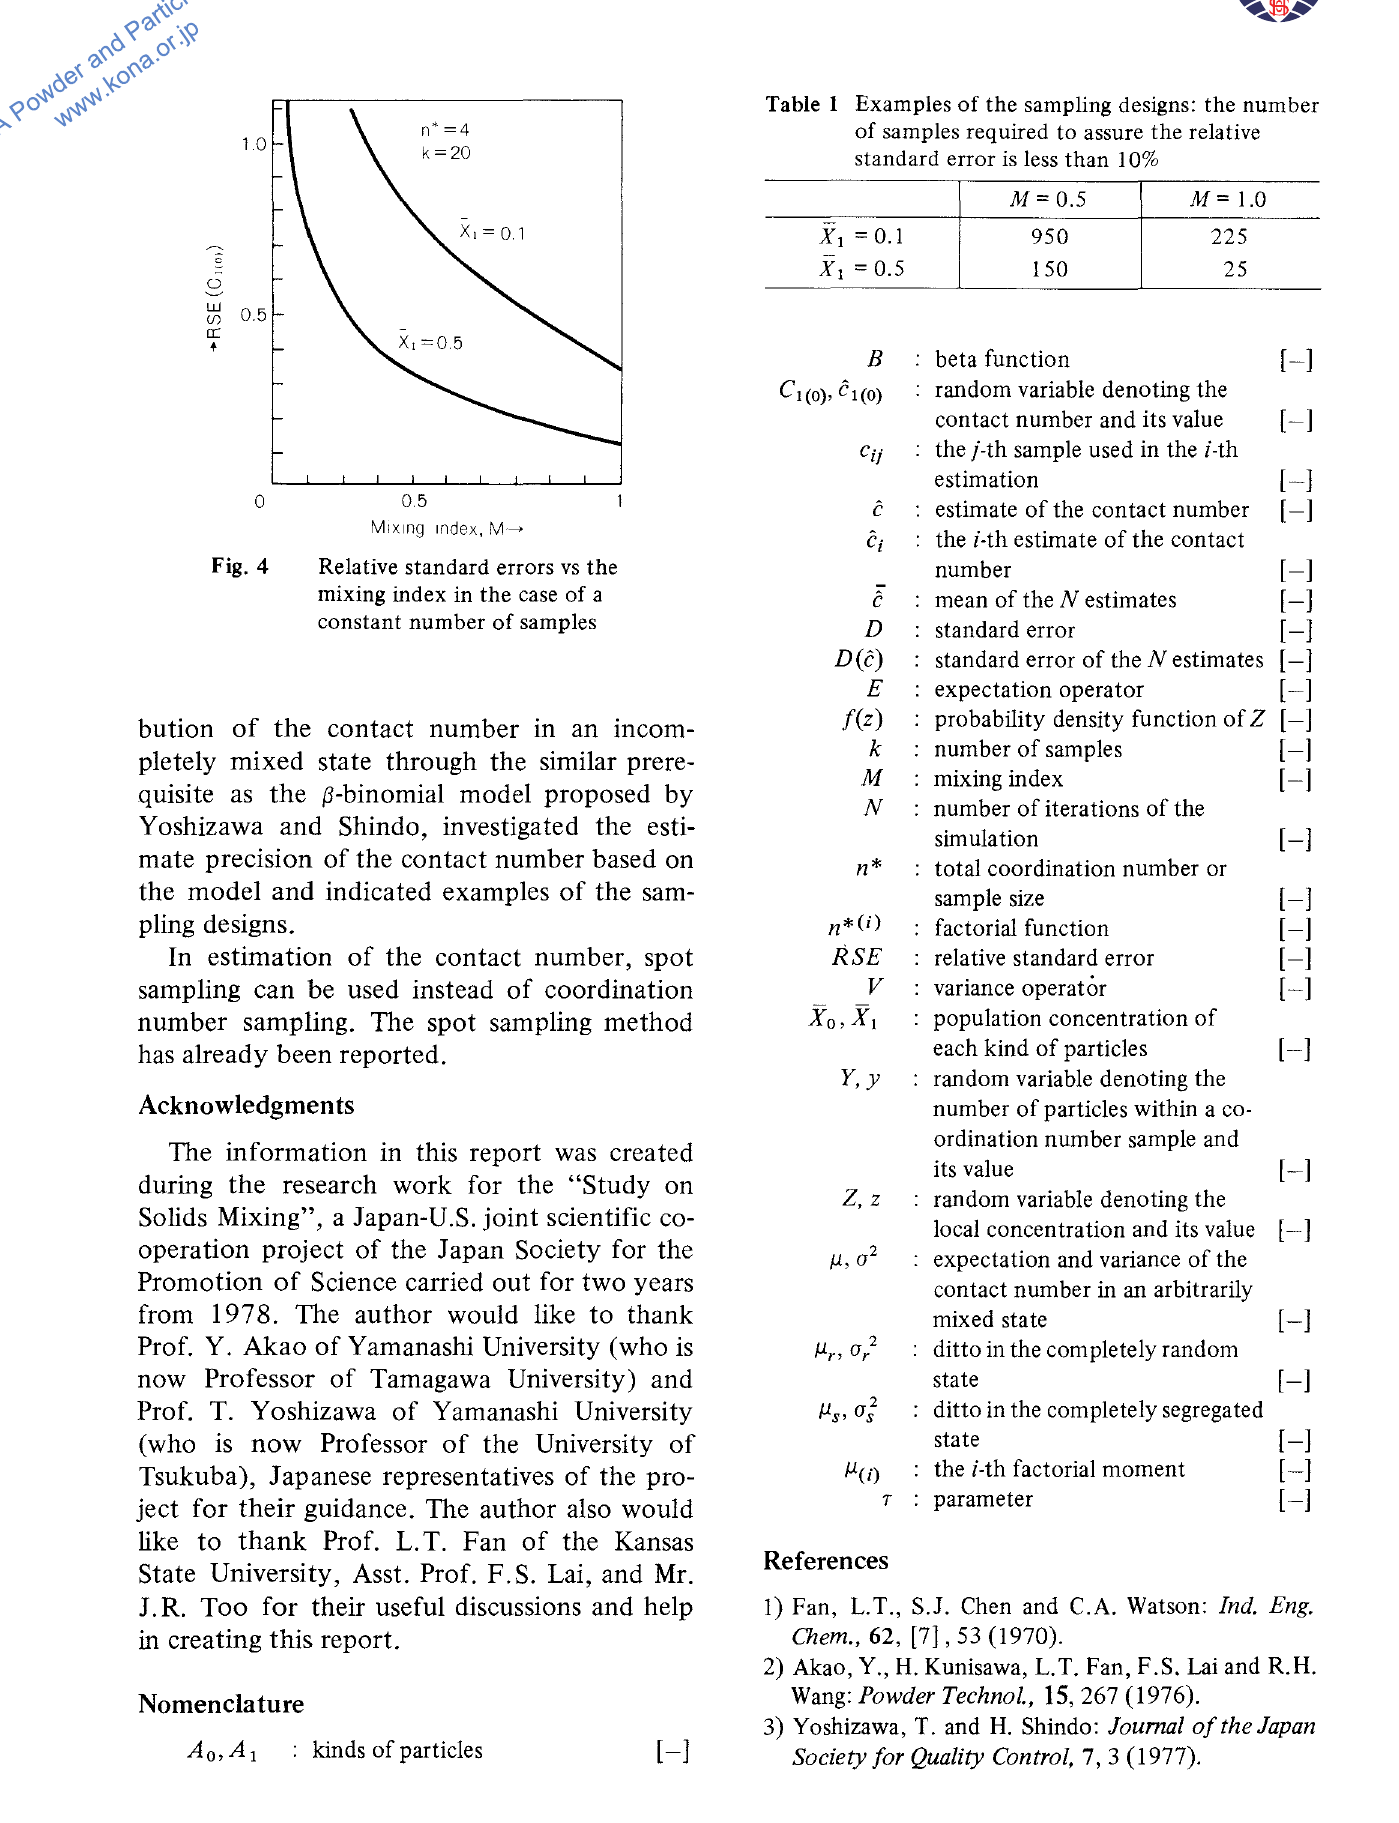
Table 1 Examples of the sampling designs: the number of samples required to assure the relative standard error is less than I